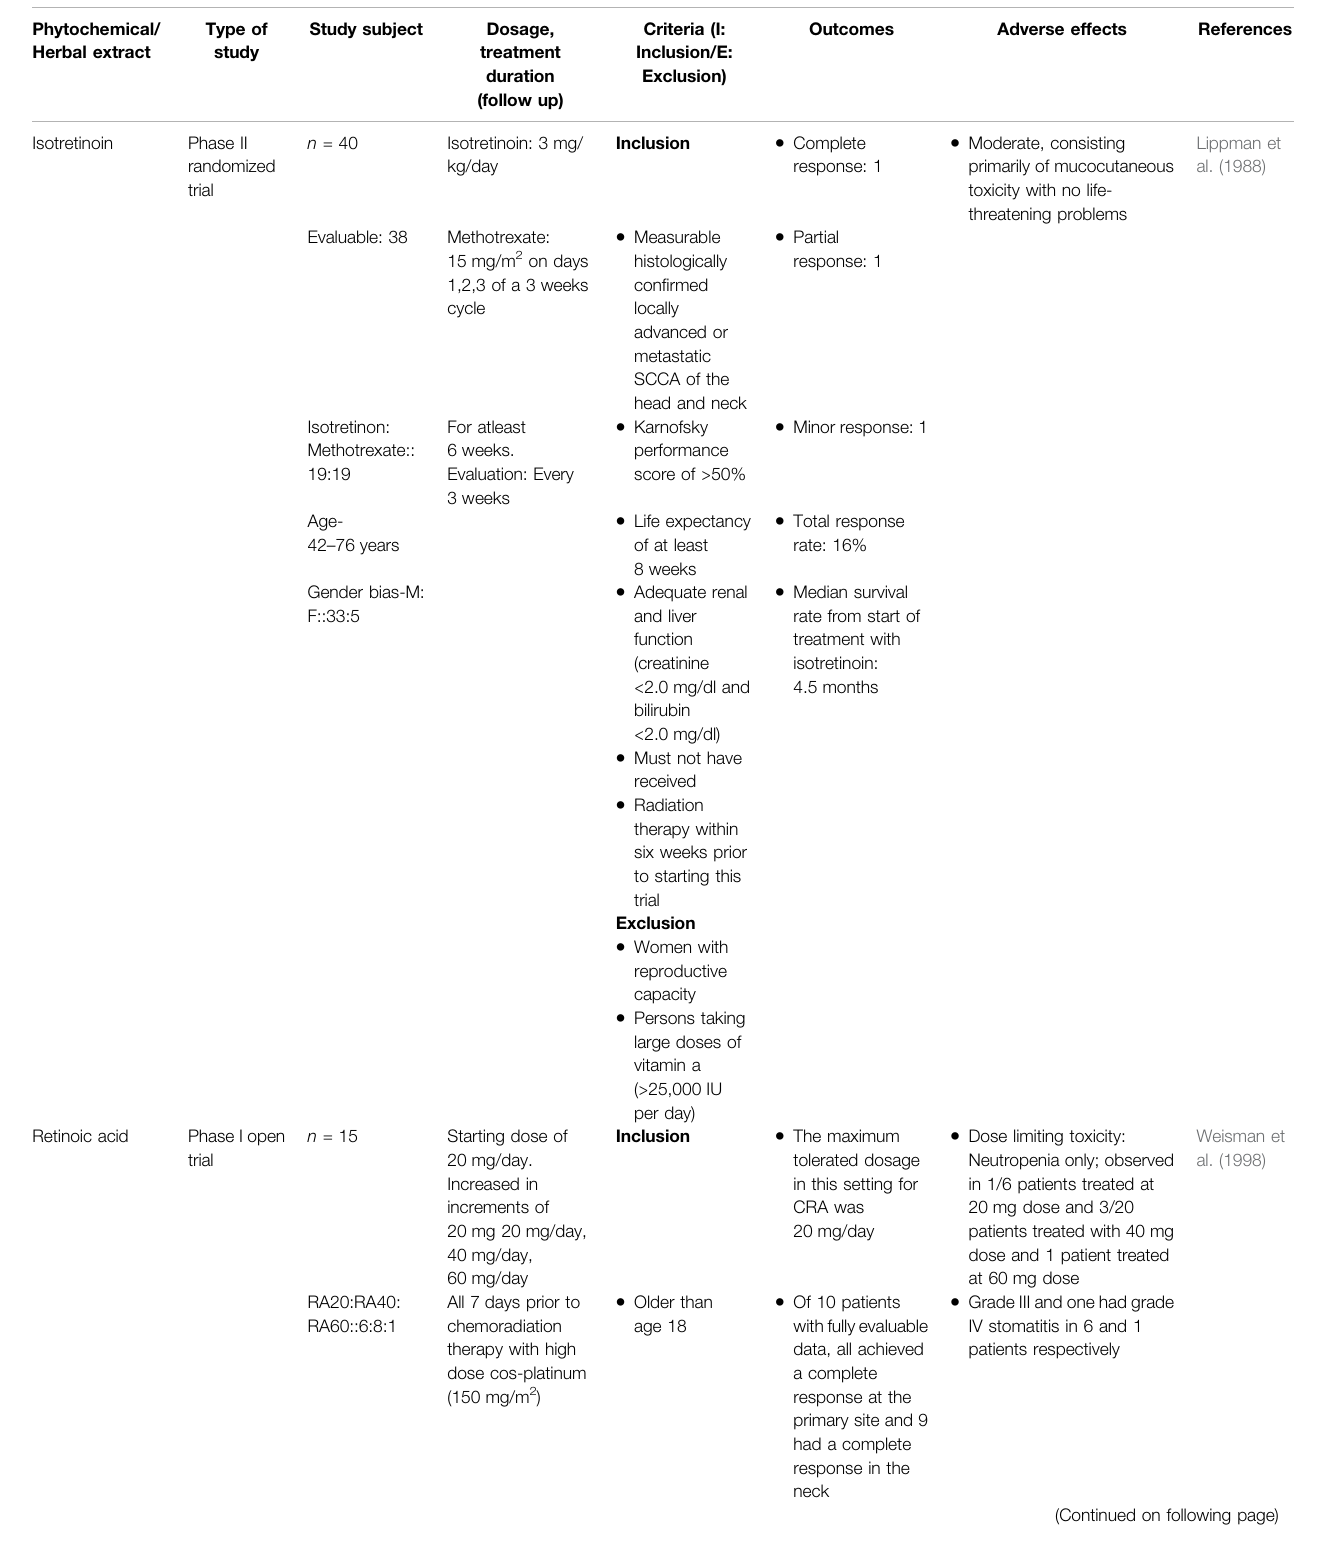
TABLE 5 | Clinical studies in therapeutic phytochemicals/herbal derivatives against HNC. Phytochemical/ Herbal